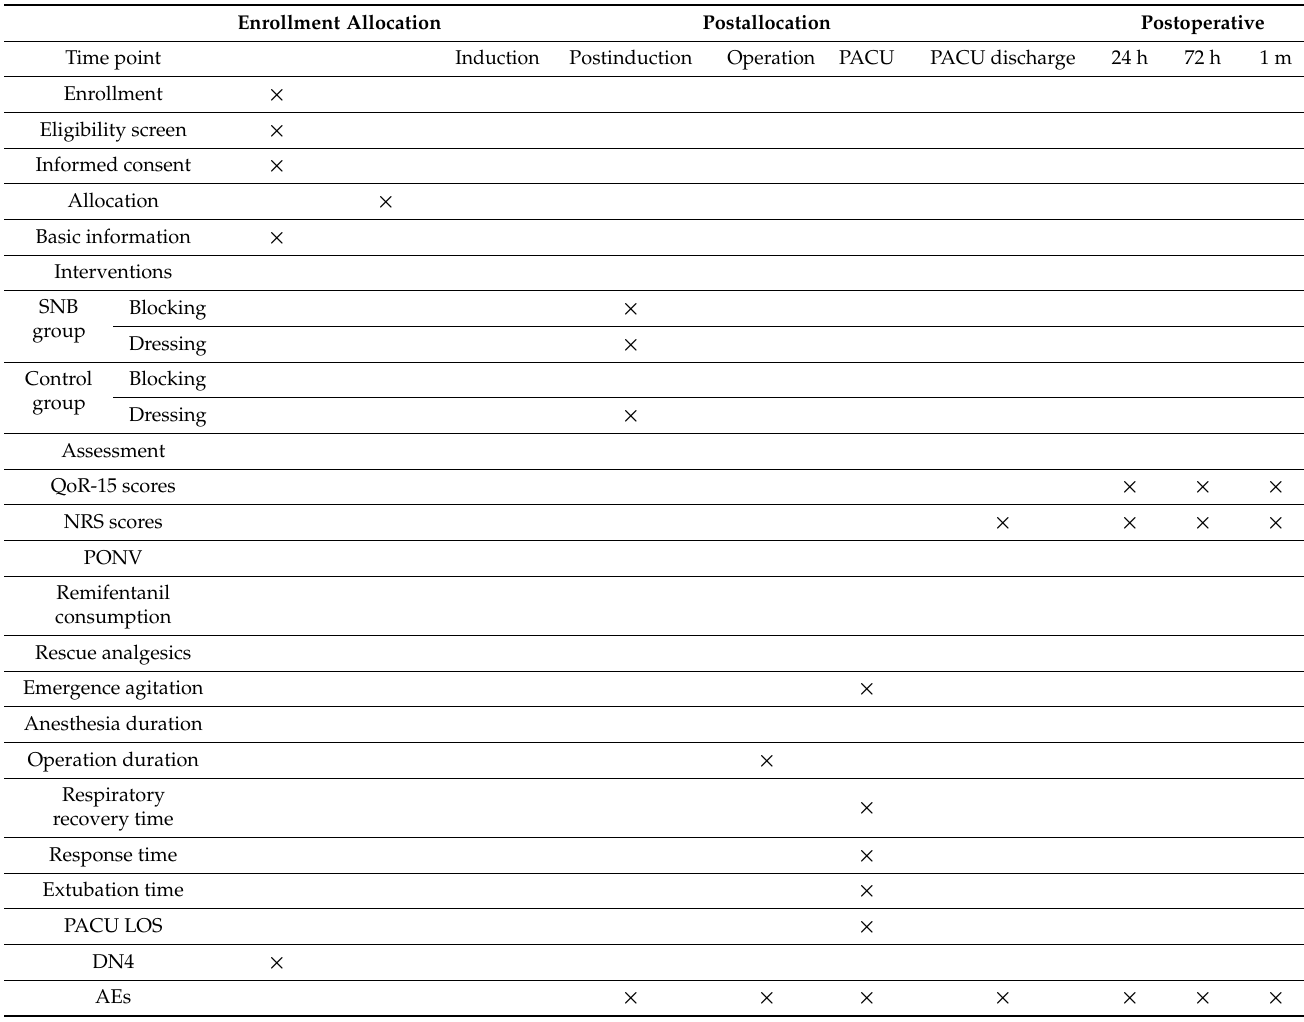
Table 1. The schedule of enrollment, interventions, and assessments for the